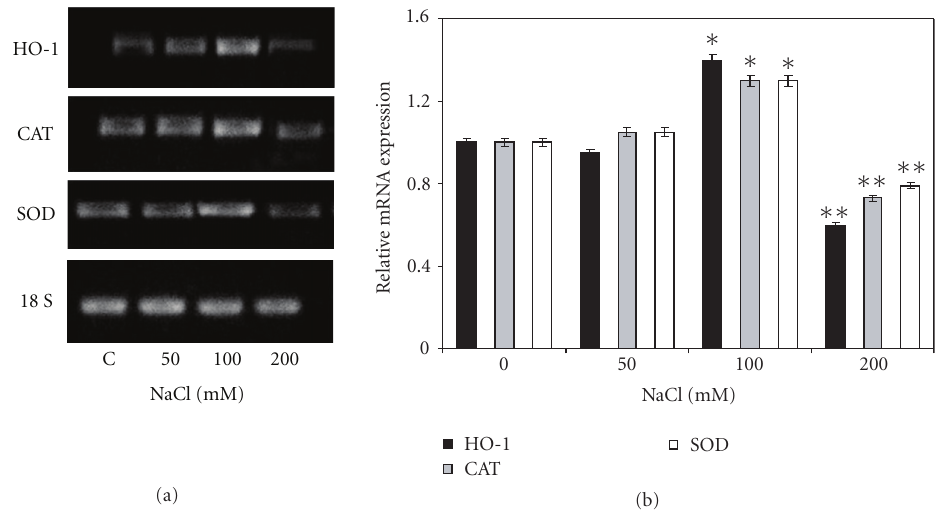
Figure 4: HO-1, CAT, and SOD gene expression in soybean leaves subjected to di ff erent NaCl concentrations (50, 100, or 200mM) during 10 days. (a) HO-1, CAT, and SOD mRNA expression was analyzed by semiquantitative RT-PCR as described in Section 2. The 18S amplification band is shown to confirm equal loading of RNA and RT e ffi ciency. (b) Relative HO-1, CAT, and SOD transcript expressions. Values are the mean of four independent experiments and bars indicate SD, ∗ P < . 01, ∗∗ P < . 001 with respect to control according to Tukey’s multiple range test. Table 2: E ff ect of ZnPPIX on HO-1 activity, TBARS levels, ion leakage, and chlorophyll content in soybean leaves subjected to salt stress.